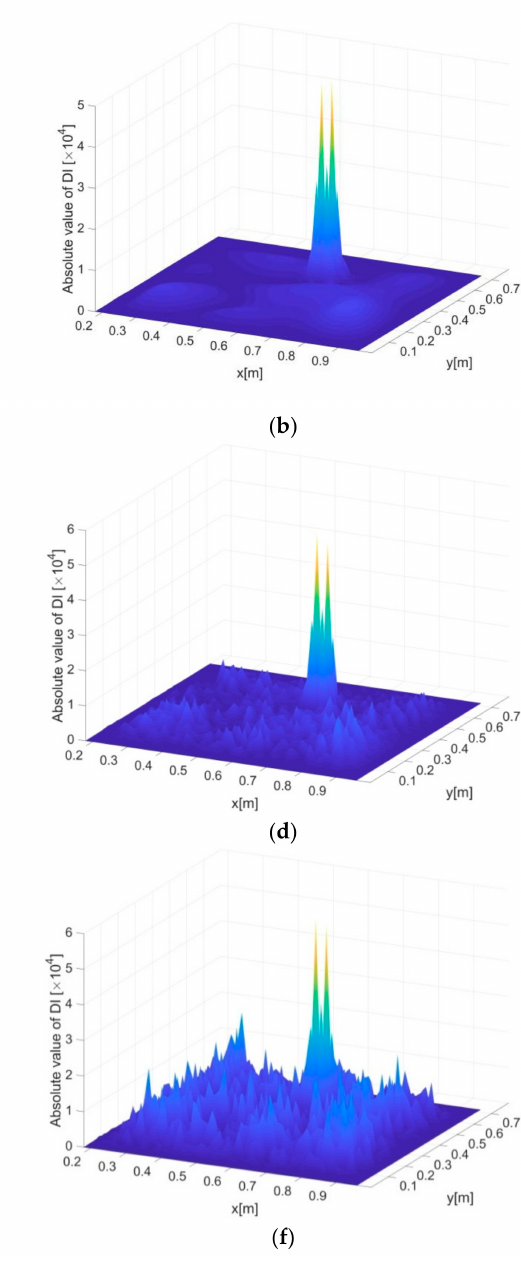
Figure 12. DI constructed based on the displacements computed by FEM and iFEM with ( a , b ) 0% ( c , d ) 1% and ( e , f ) 5% noise in level, subjected to measurement inter-distance of 15